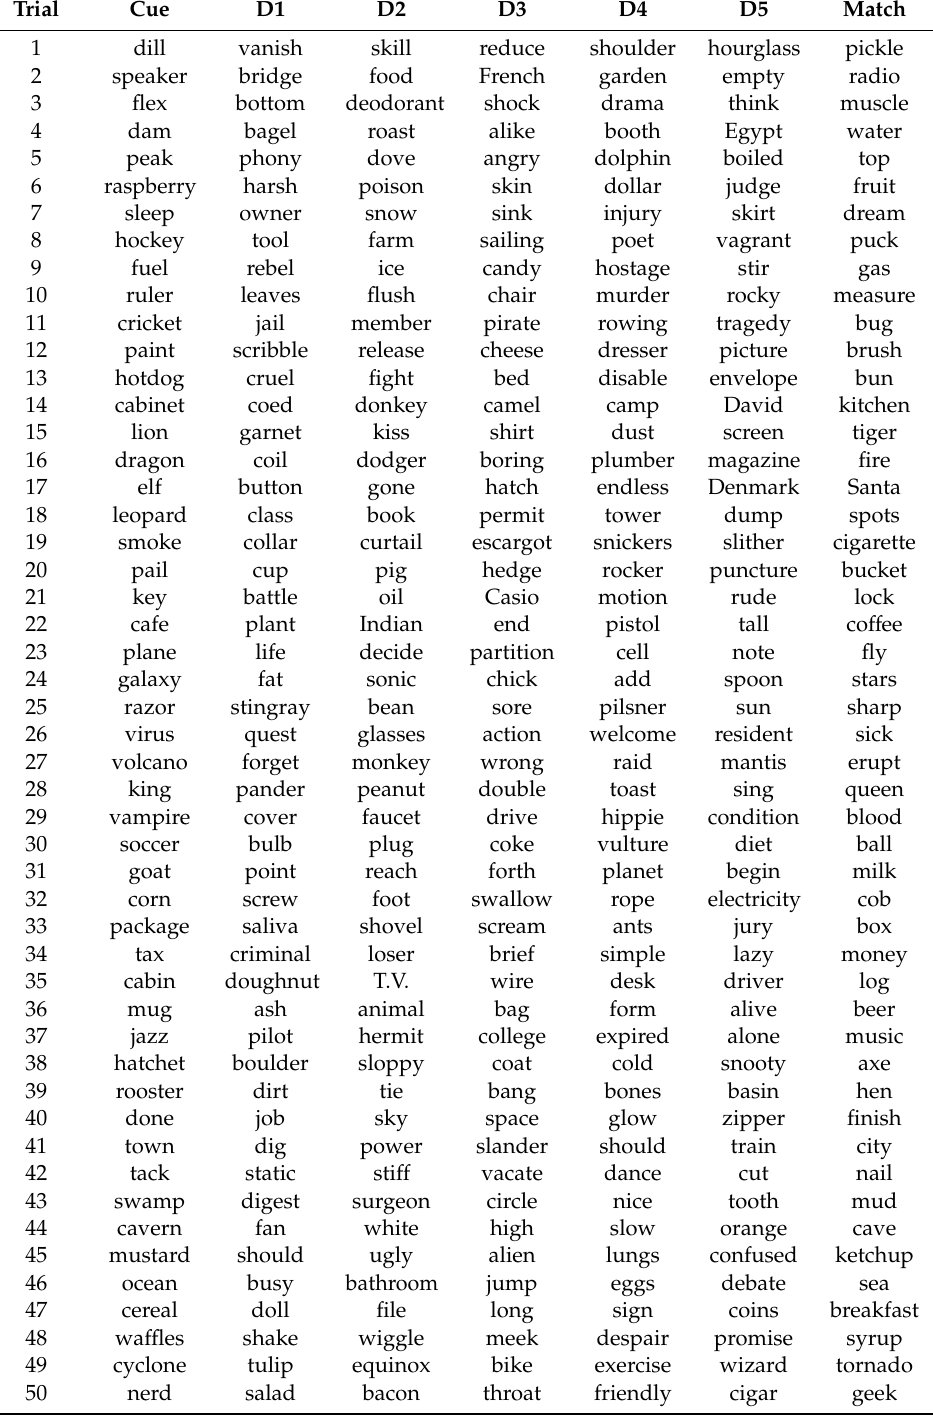
Table A1. Complete list of Stimuli for Experiment